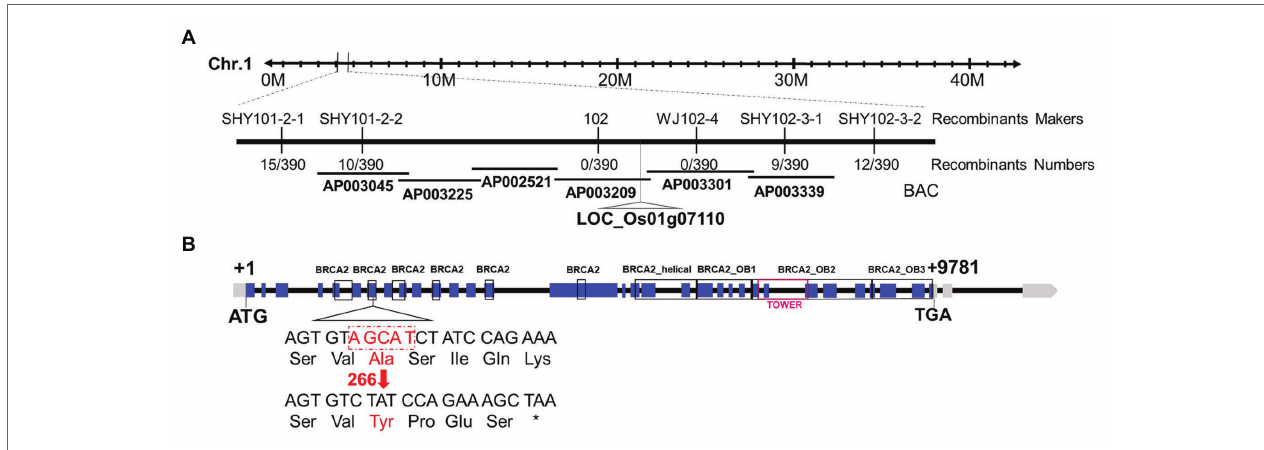
FIGURE 2 | Molecular characterization of osbrca2-1 . (A) Fine mapping of osbrca2-1 on chromosome 1. Names and positions of the markers are indicated. (B) A schematic representation of 32 exons and 31 introns of LOC_Os01g07110. The +1 indicates the putative starting nucleotide of translation, and the stop codon (TGA) is +9781. Blue boxes indicate exons, and intervening lines indicate introns. The deletion site in osbrca2-1 is shown (red